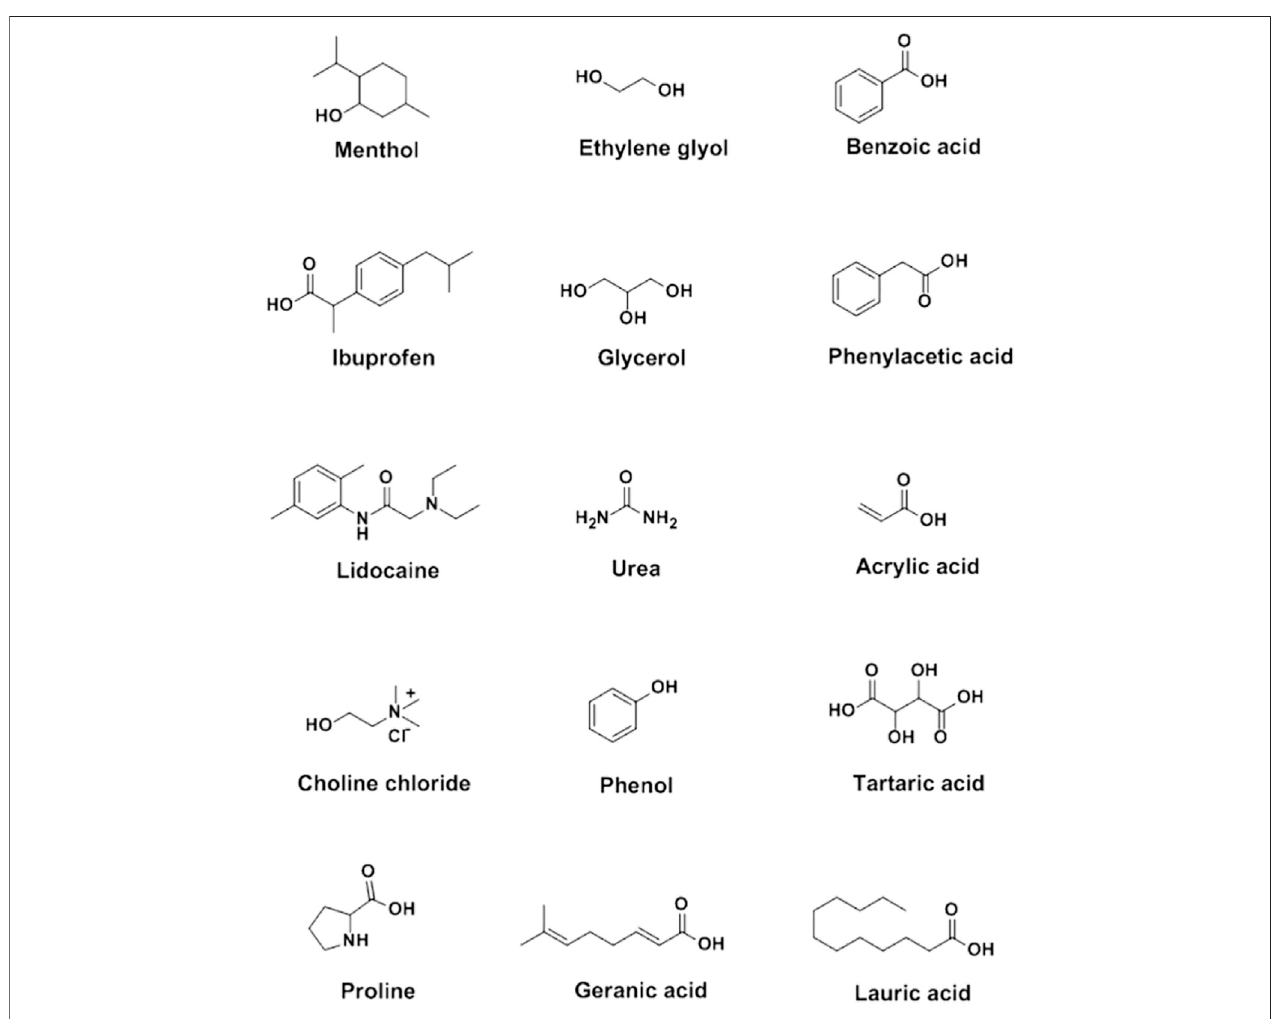
FIGURE 1 | Chemical structures of the general components in synthesis of DESs.